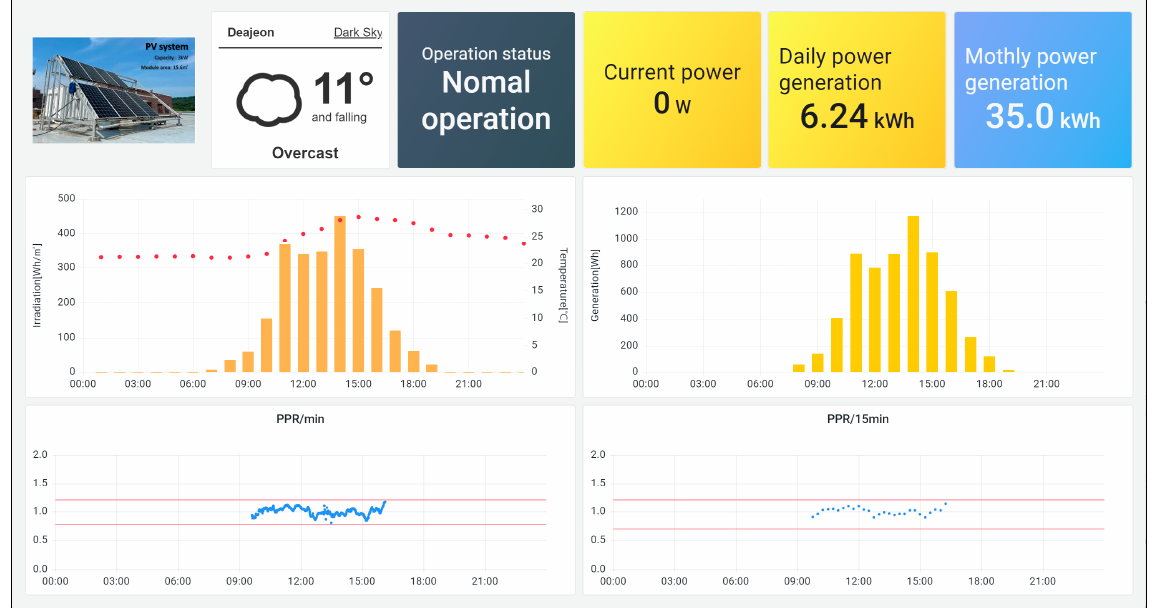
Figure 6. Web screen of PV remote monitoring system.